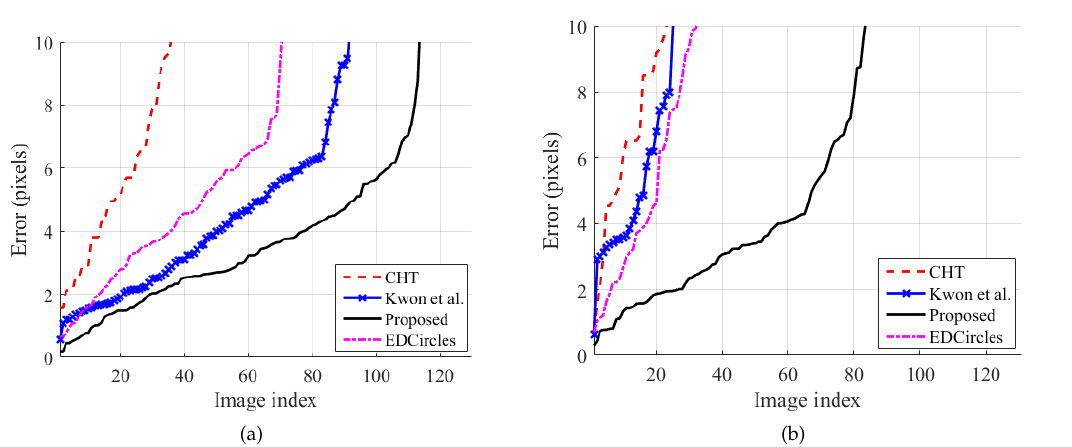
Figure 8. Circle detection accuracy. ( a ) Gym ball set. ( b ) Basketball set. The error is the distance from the best circle center detected by a method to its manually-recorded ground-truth center. For each method, the error has been sorted in ascending order, so the image indices do not match across the methods. Best viewed in